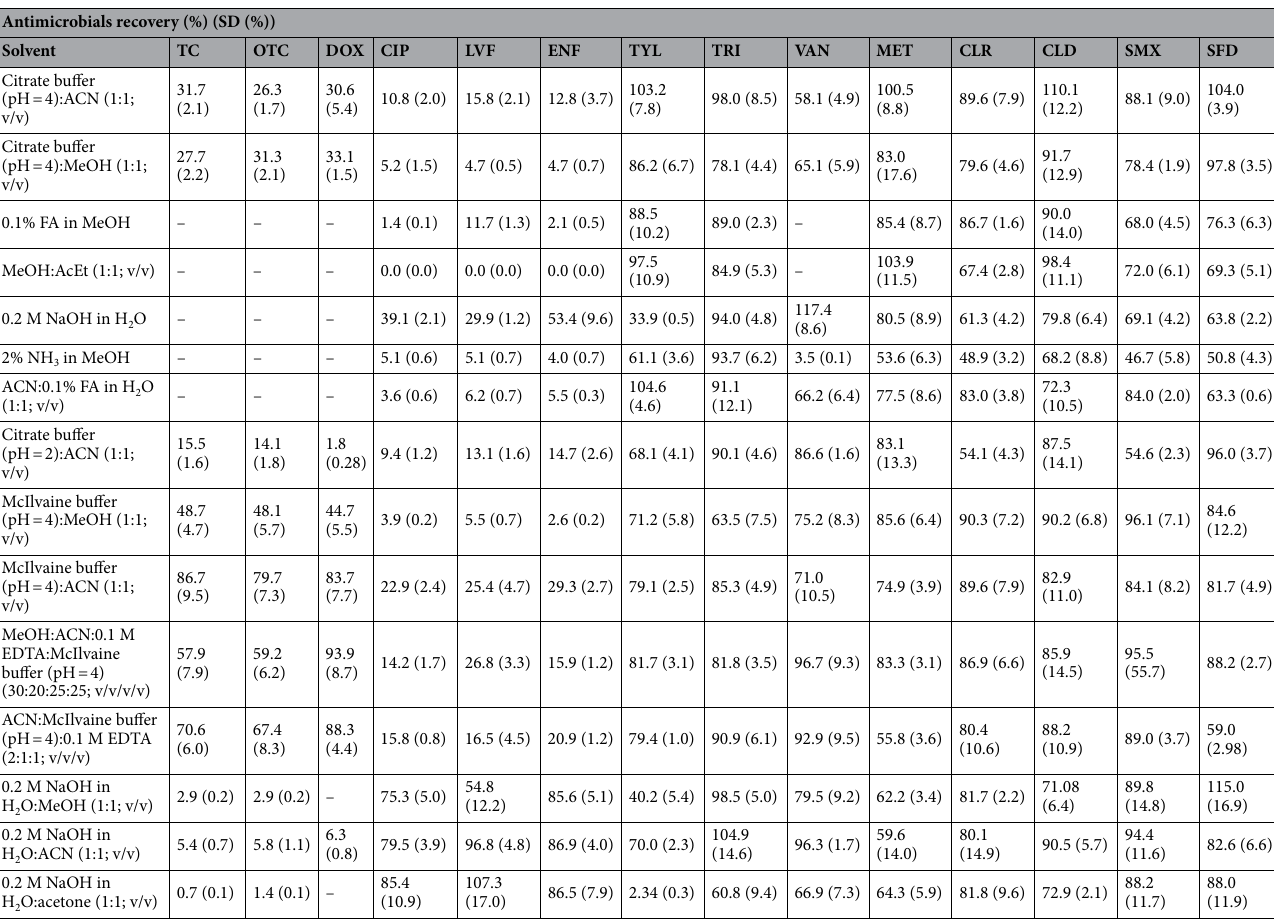
Table 1. Effect of the solvent in SLE procedure applied for extraction antimicrobials from soil. ACN— acetonitrile, FA—formic acid, AcEt—ethyl acetate, “–”—no data (no peak in the